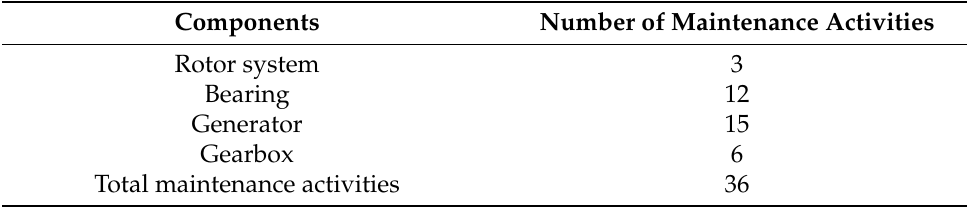
Table 5. Component’s maintenance frequency in 240 months.